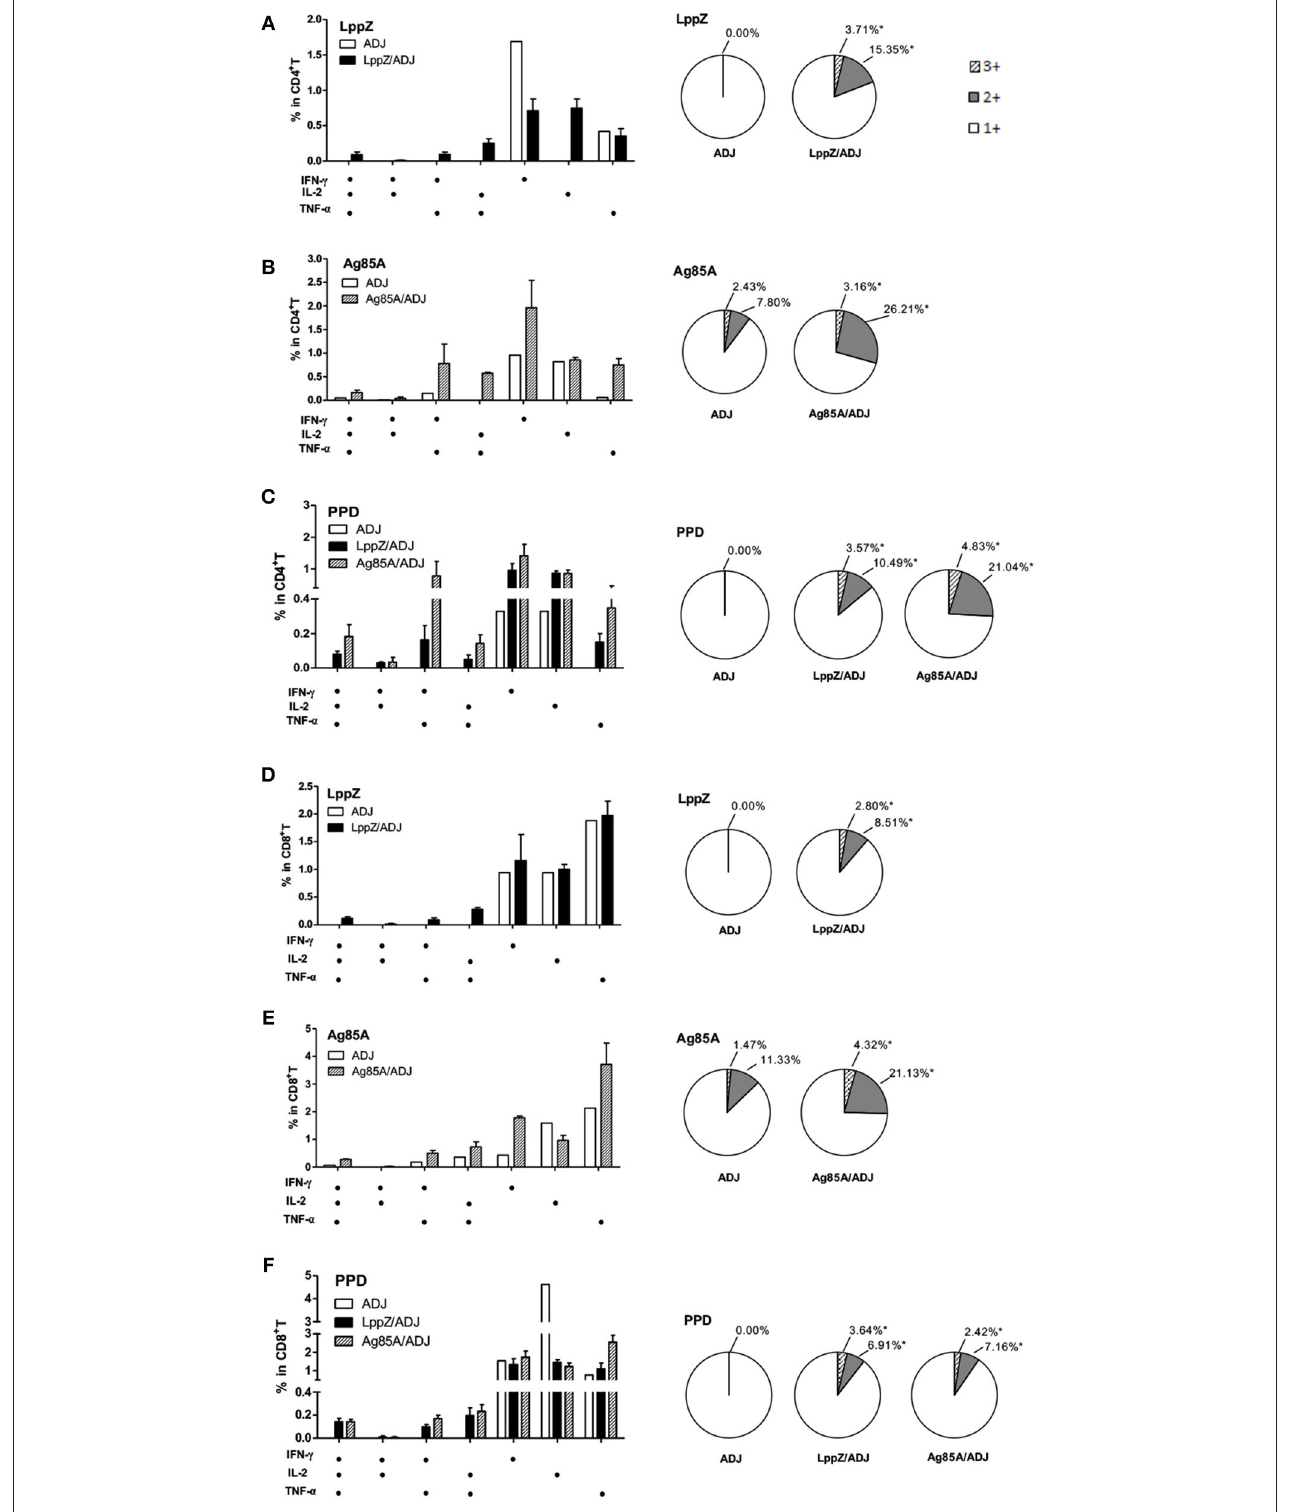
FIGURE 7 | Polyfunctional CD4 + and CD8 + T cell distribution in the lungs of the immunized mice after H37Rv challenge. Pulmonary lymphocytes from different groups (ADJ, LppZ/ADJ or Ag85A/ADJ) were collected and stimulated ex vivo with LppZ (A,D) , Ag85A (B,E) or PPD (C,F) . Frequencies of antigen-specific CD4 + or CD8 + T cells producing single or multiple cytokines were analyzed by flow cytometry. Single or multiple cytokine production was shown on the x-axis of the bar chart. The percentages of T cells expressing single (1 + ), double (2 + ) or triple (3 + ) cytokines were represented as pie charts. * p < 0.05.